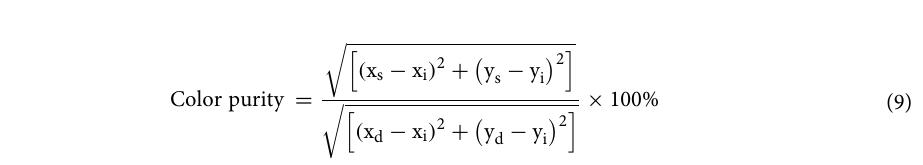
Figure 11. ( a ) PL excitation and ( b ) emission spectra of Sr 1−x Al 2 O 4 :Eu x (x = 0.00, 0.01, 0.03, 0.05, 0.07, and 0.09) phosphor (SAE